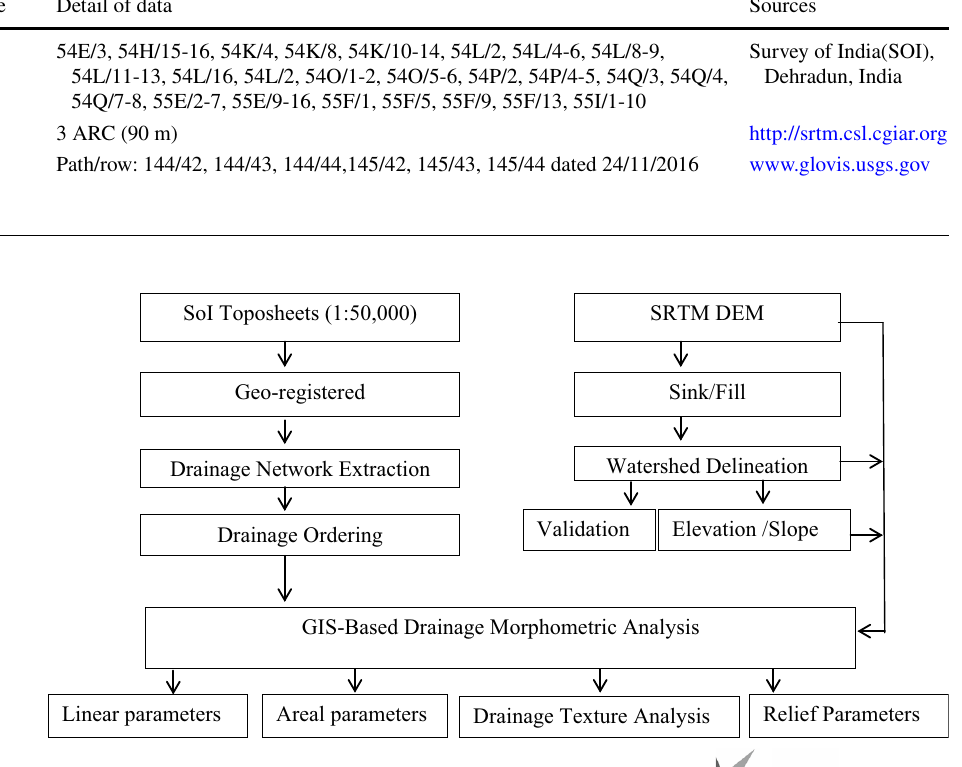
Table 1 Data used in the present work Sl. no.